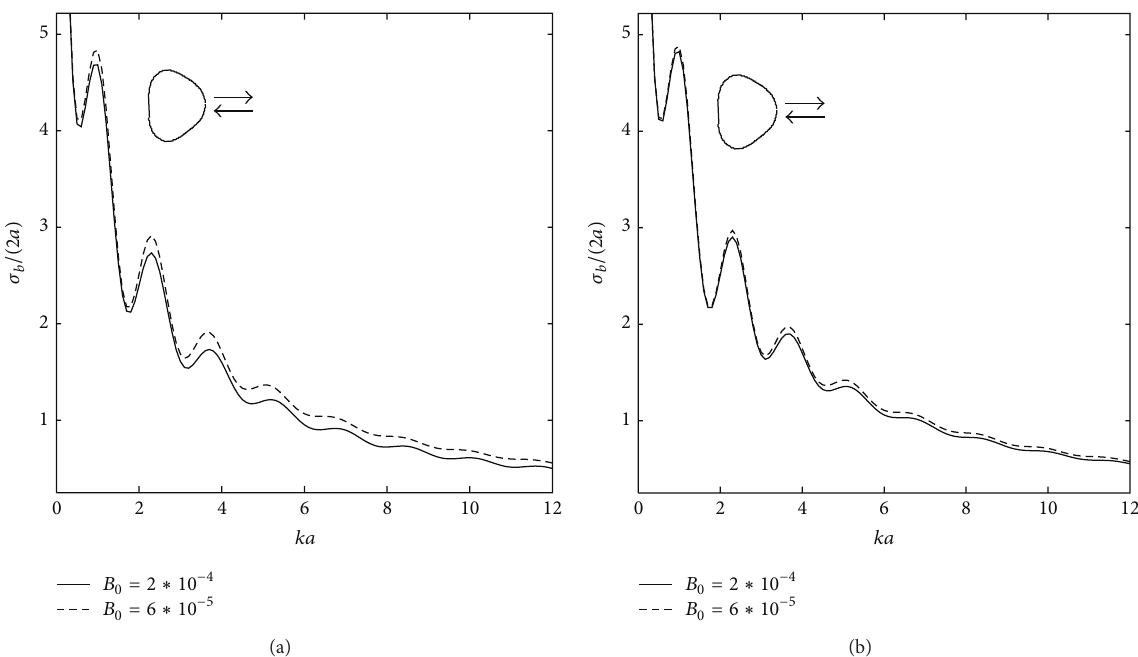
Figure 4: LRCS versus target size for 𝛿 = 0.09 and 𝑘𝑊 = 1.5 where the target is located in random medium with (a) SCL = 3, (b) SCL = 5.2.